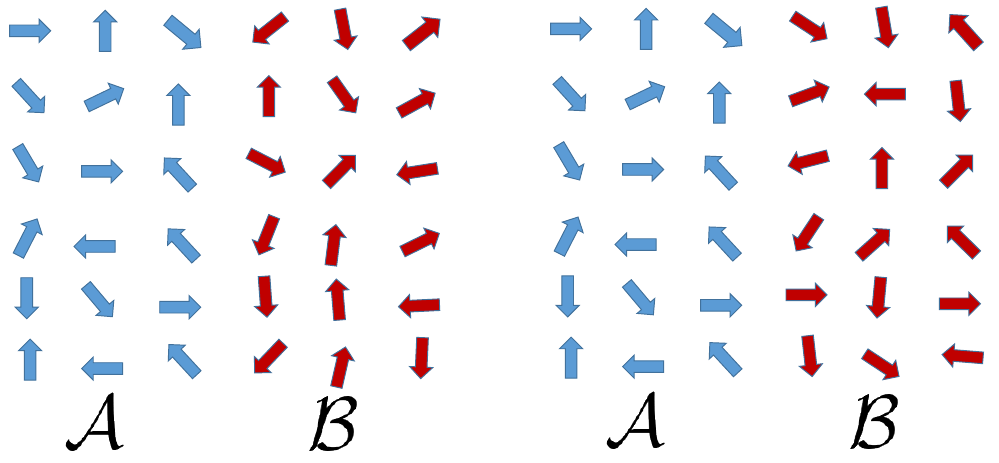
and . Regions of the A B A is accepted only A